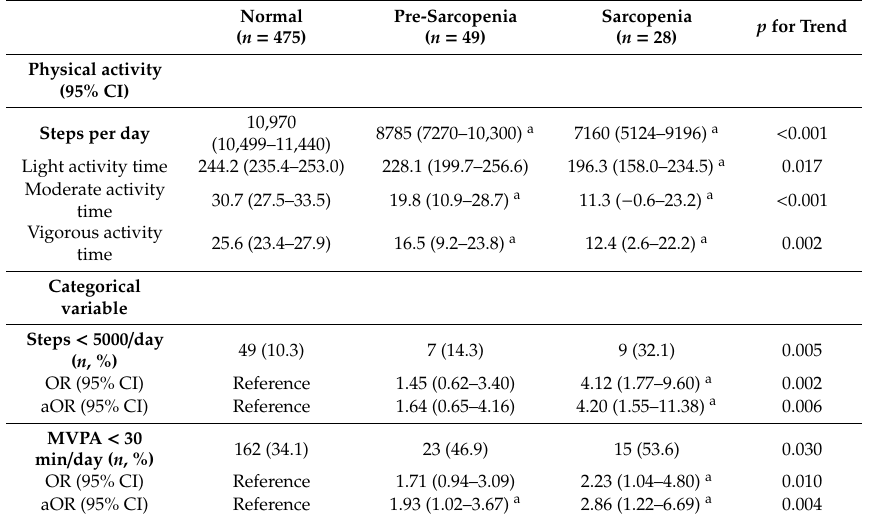
Table 3. Di ff erences of preoperative physical activity measured using Fitbit by sarcopenia status. Normal ( n = sarcopenia group defined according to skeletal muscle mass. Sarcopenia: sarcopenia group defined